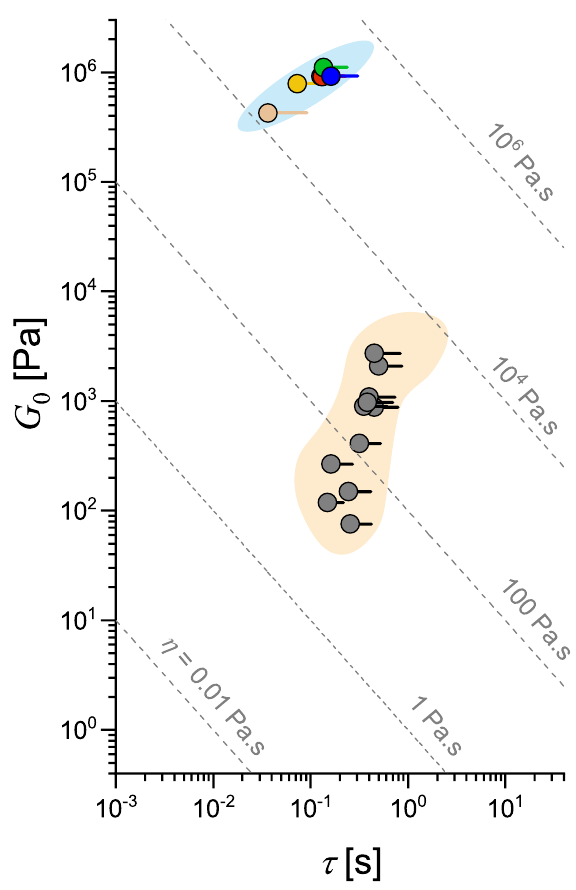
Figure 14: Ashby-style plot of high-dimensional linear viscoelastic behavior onto two-dimensional coordinates for the putties (color symbols at top) and the PVA-Borax (gray symbols in middle). Sym- bols are centered at coordinate location ( τ 1 , G 0 ) with a “tail” ex- tending to a value of τ 2 to indicate the polydispersity of relaxation